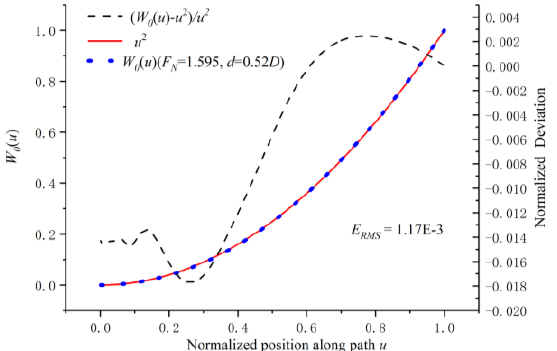
Figure 1. Normalized path-weighting function of log-amplitude covariance for plane waves W 0 ( u ) (dotted line) with d = 0.52 D and F N = 1.595. Path-weighting function u 2 and the normalized deviation ( W 0 ( u ) − u 2 )/ u 2 (dashed line) are also given for comparison.